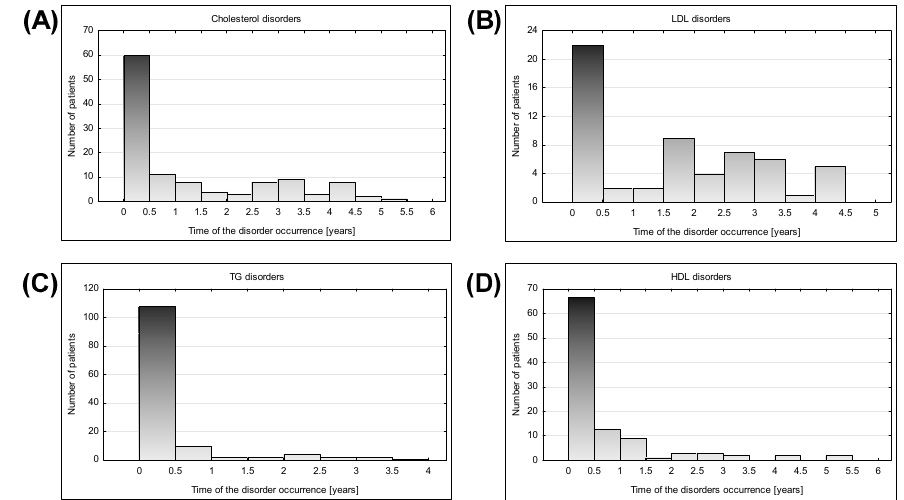
Figure 5. Time distribution of the lipid disorders at time point 2 (disorder first appearance after HSCT) occurrence among patients; x-axis is the time of the disorder occurrence after HSCT [years] and the y-axis is the number of children that developed the disease; ( A ) Cholesterol disorders—Shapiro-Wilk p < 0.00001, average 0.726, SD 1.087, variance 1.181, population 113, median 0.275; ( B ) LDL disorders—Shapiro-Wilk p < 0.00001, average 1.11, SD 1.363, variance 1.858, population 44, median 0.365; ( C ) Triglycerides disorders—Shapiro-Wilk p < 0.00001, average 0.388, SD 0.713, variance 0.509, population 131, median 0.0972; ( D ) HDL disorders—Shapiro-Wilk p < 0.00001, average 0.704, SD 1095, variance 1198, population 102, median 0.254.